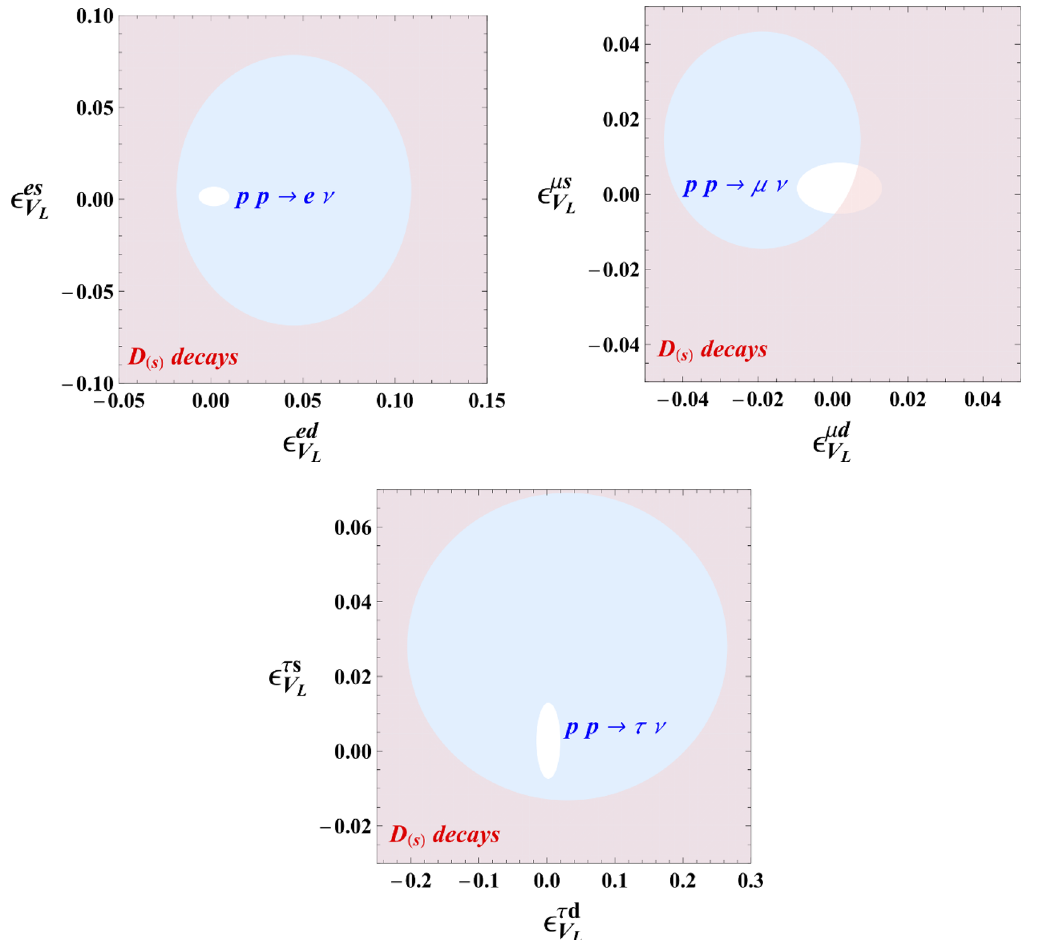
Figure 2 . Exclusion limits at 95% CL on c → d ( s )¯ e α ν α transitions in ( (cid:15) ααd (top left), α = µ (top right), and α = τ (bottom). The region colored in pink is excluded by D meson decays, while the region colored in blue is excluded by high- p T